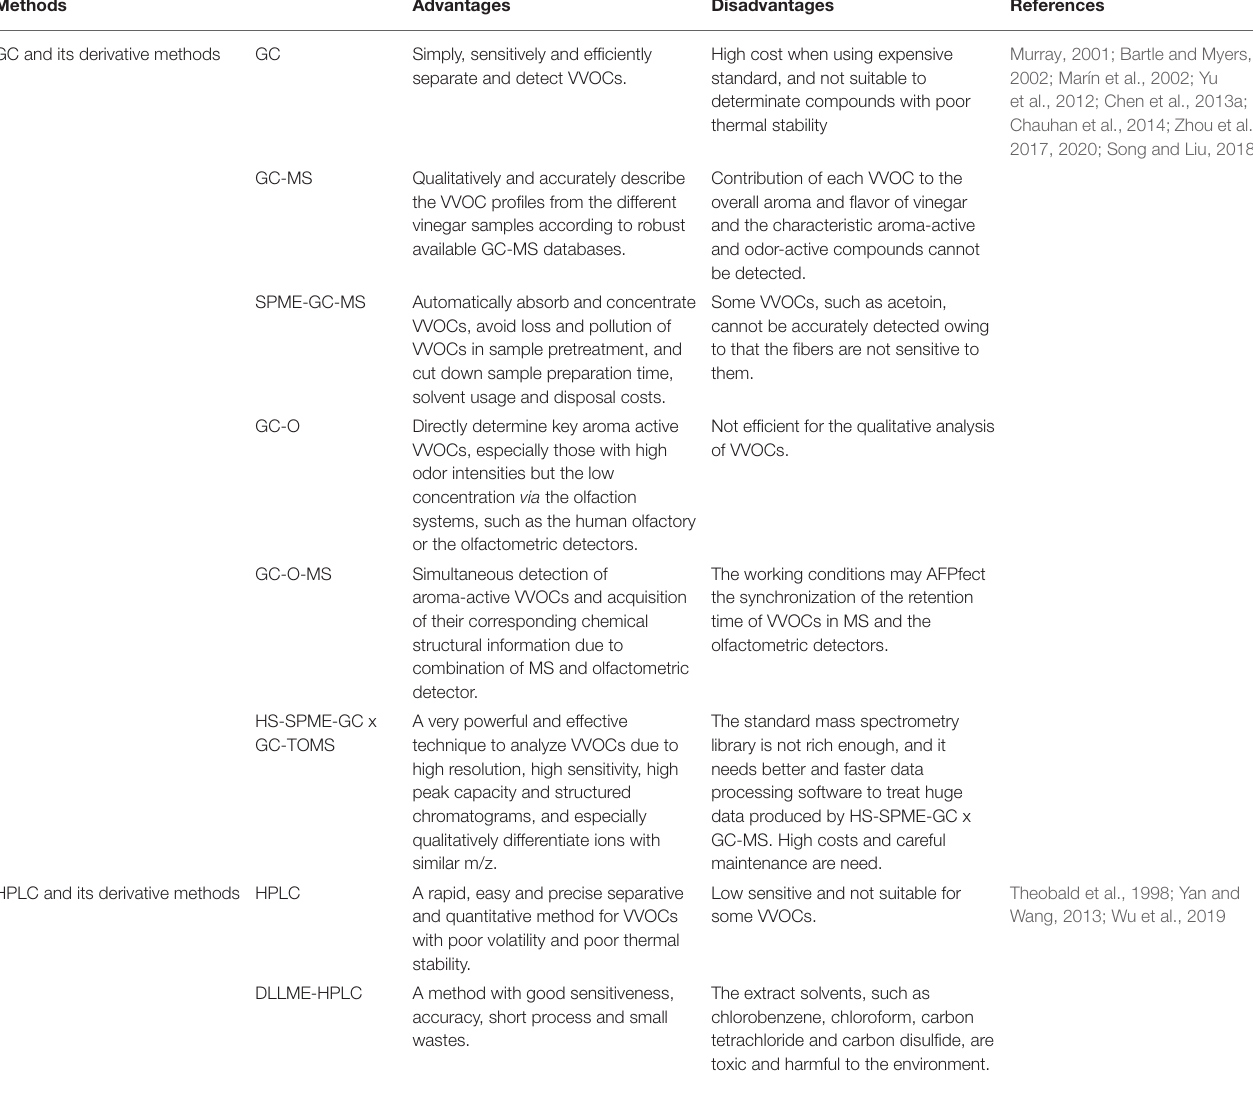
TABLE 2 | Advantages and disadvantages of GC, HPLC, and their derivative methods to analyze